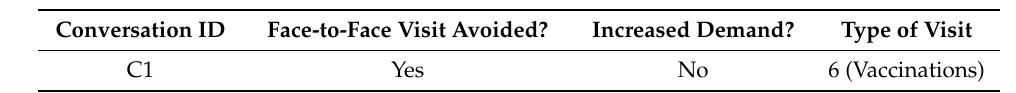
Table 2. Annotation by the